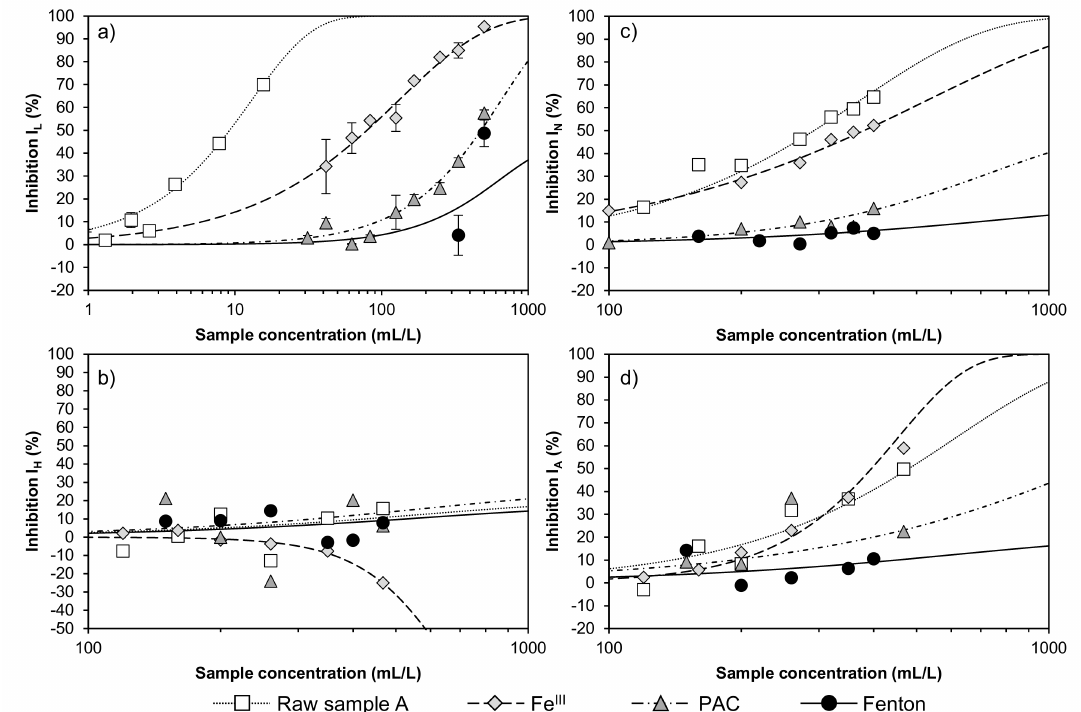
Figure 4. Inhibition of luminescent bacteria ( a ); heterotrophic activated sludge bacteria ( b ); nitrifying activated sludge bacteria ( c , d ) as determined by the nitrification inhibition test ( c ) and the respiration inhibition test ( b , d ) as a function of the sample concentration of sample A before and after treatment with precipitation/flocculation (81 mg/L Fe III ), 1125 mg/L PAC and Fenton reagent (309 mg/L Fe II and 1030 mg/L H 2 O 2 at pH 2.3–2.5) at the scale of 10